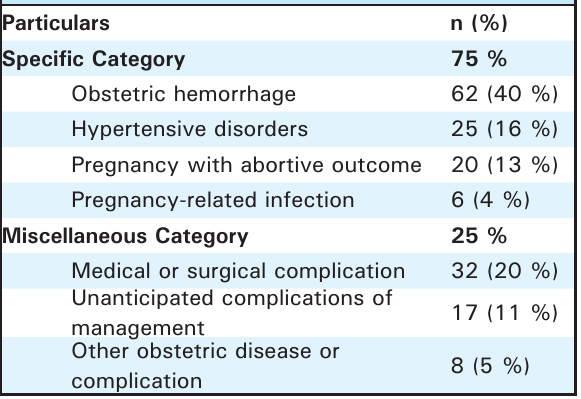
Table 7. Reasons for being categorized as near-miss (>1 condition in